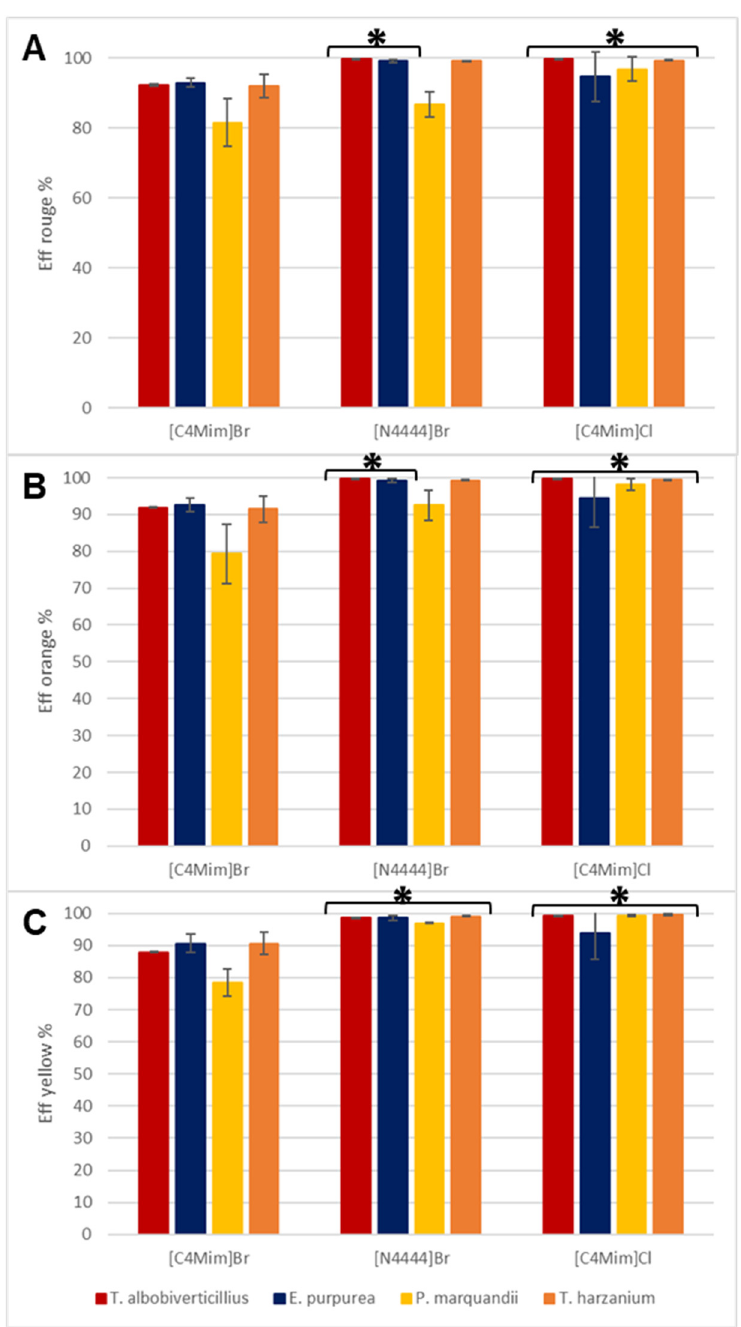
Figure 5. Direct extraction efficiency of red (490 nm) ( A ), orange (470 nm) ( B ) and yellow (400 nm) ( C ) pigments for each strain in the four IL-ATPSs tested (* indicate p -values < 0.05, n = 3).